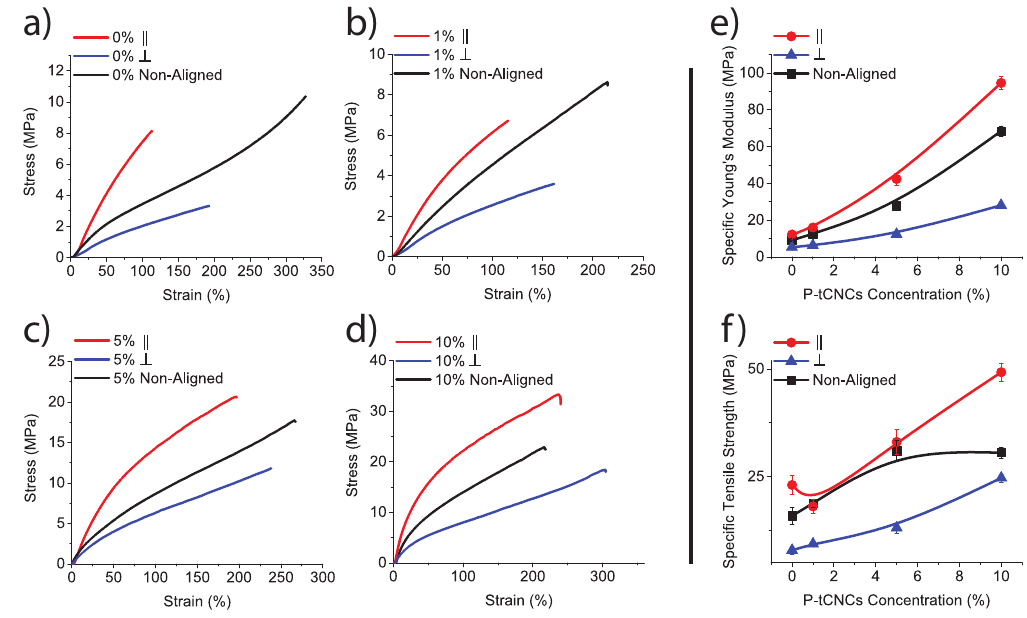
Figure 5. ( a ) Stress–strain curves of electrospun fibrous mats with: ( a ) 0 wt% P-tCNCs; ( b ) 1 wt% P-tCNCs; ( c ) 5 wt% P-tCNCs; and ( d ) 10 wt% P-tCNCs in PU with different fiber orientations,